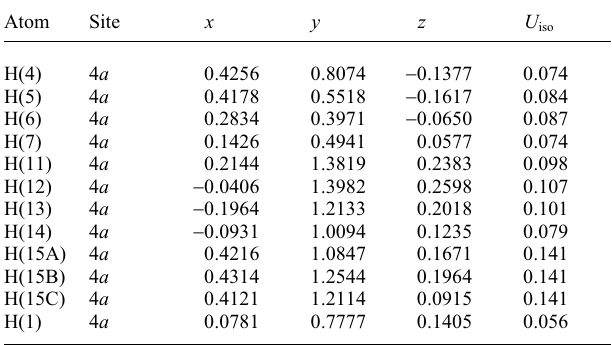
Table 2. Atomic coordinates and displacement parameters (in Å 2 ) .